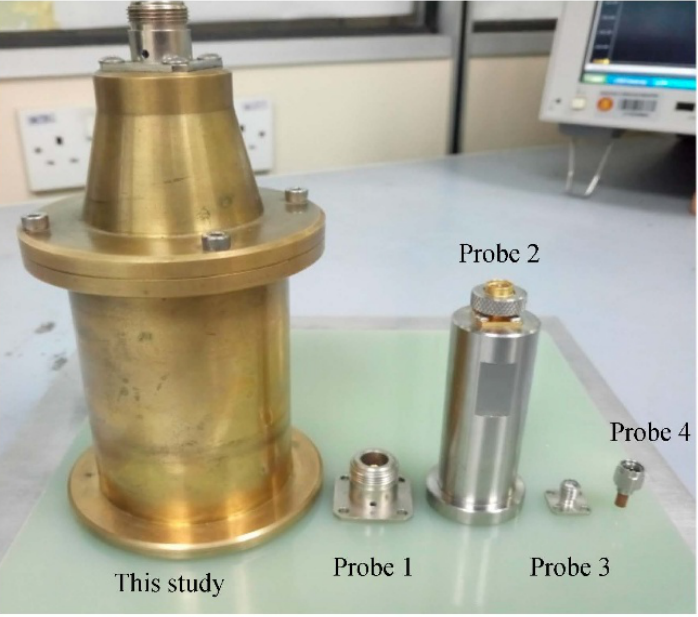
Figure 10. Various sizes of coaxial probe. Table 2. Measured |Γ AA ′ | for Teflon and FR-4 sheets with thickness of 1 mm backed by metal plate at 50 MHz.